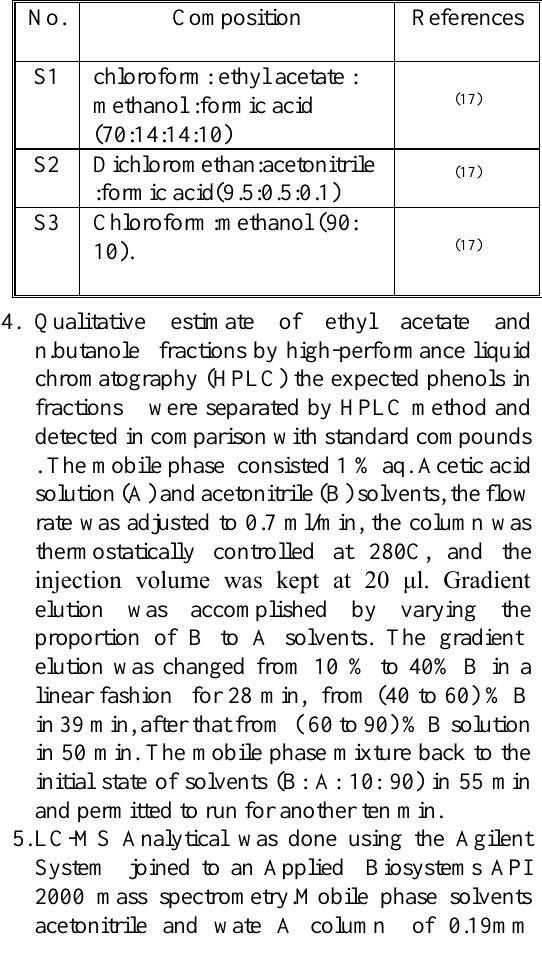
Table 1. Developing solvent systems using in the separation of phenols in Borago Officinalis.